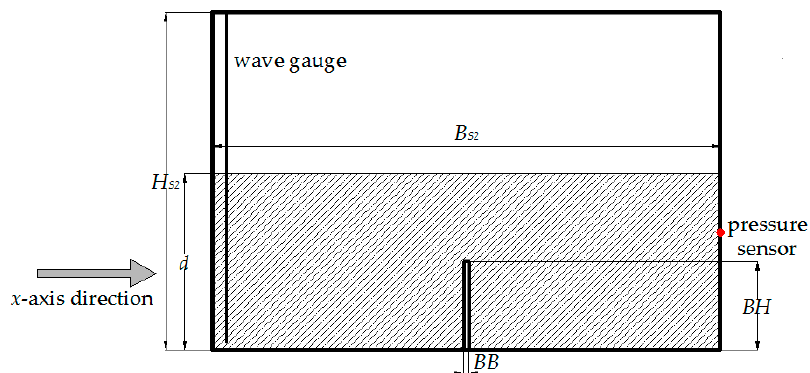
Figure 23. Configuration of the sloshing water tank.